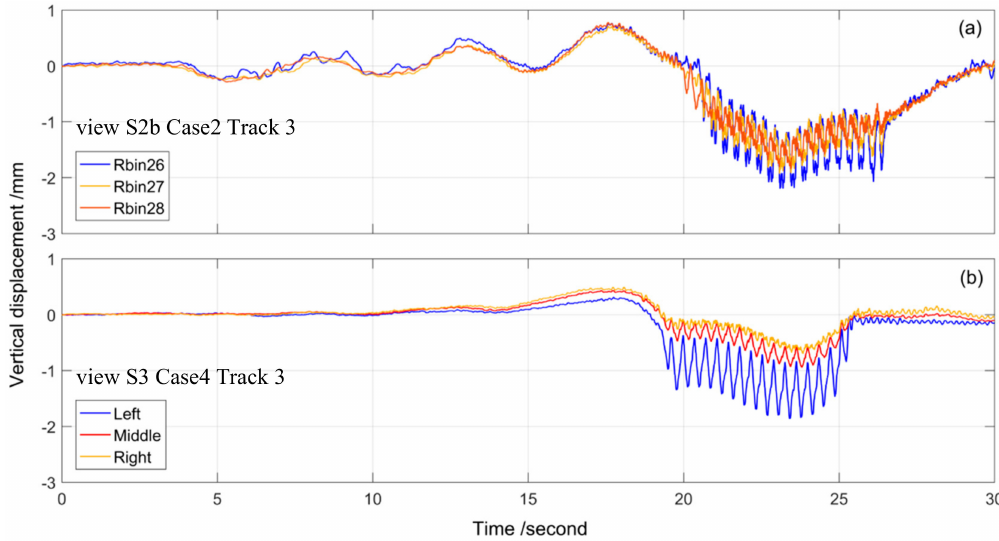
Figure 19. Vertical displacements in ( a ) view s2b case 2 track 3 and ( b ) view s3 case 4 track 3. the ‘left’, ’middle’ and ’right’ are the radar bins selected at the corresponding position in the bridge